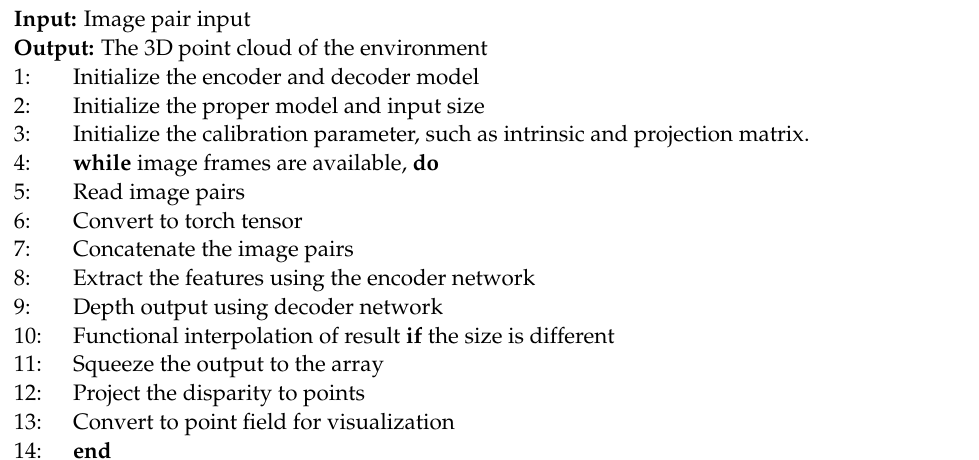
Algorithm 1. The overall steps: image to point cloud generation.